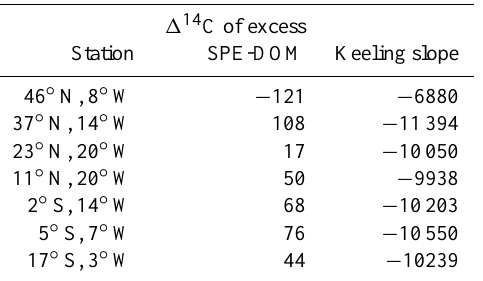
Table 4. Calculated 1 14 C values of excess SPE-DOM and corresponding Keeling slope values for the seven deep stations of the eastern Atlantic Ocean.